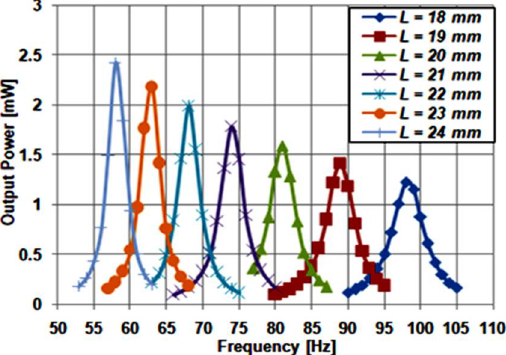
Figure 2. Modified structure frequency response at different lengths.